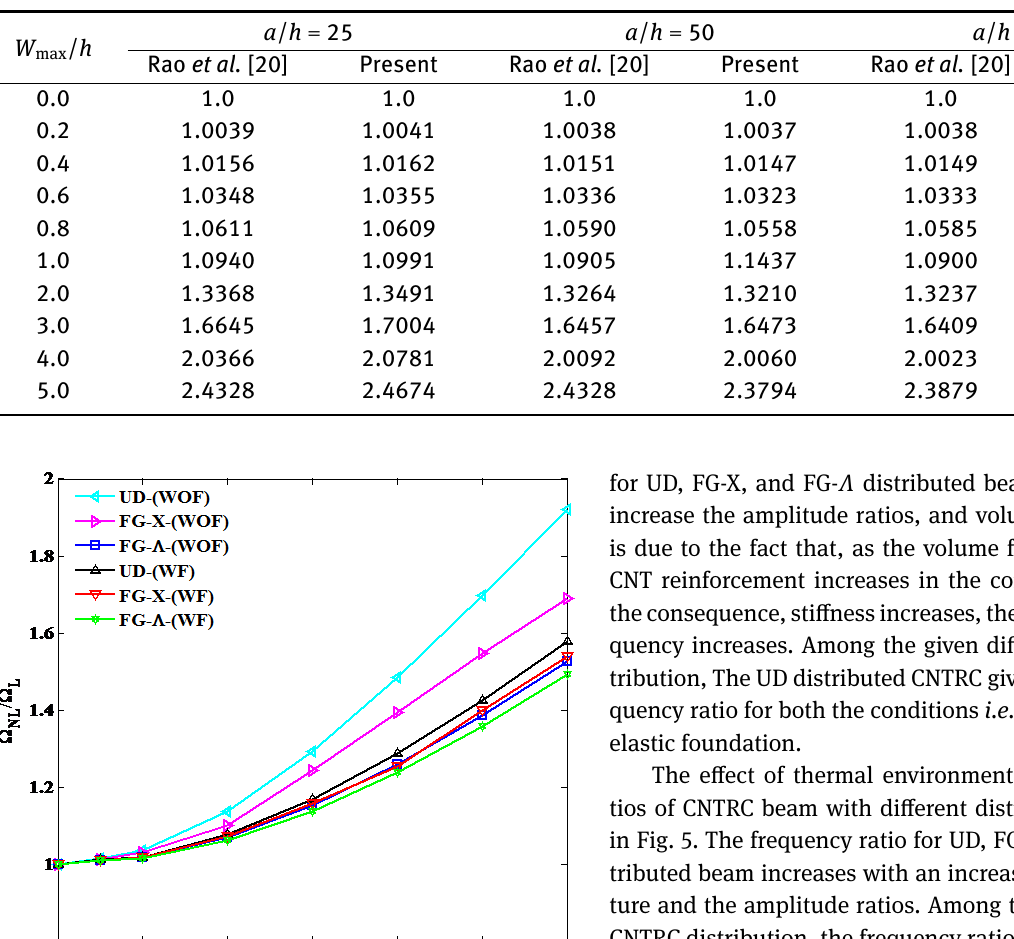
Table 4: Comparison of nonlinear to linear frequency ratio(R) of isotropic beam.